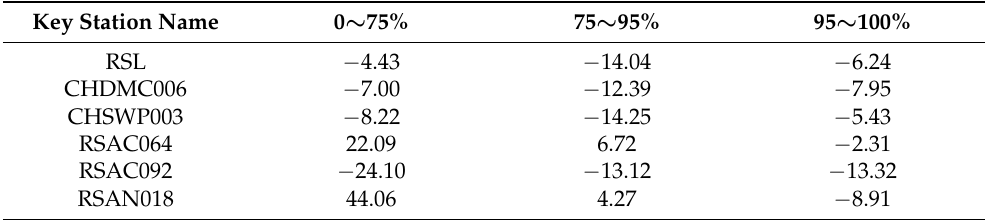
Table A2. Values of ∑ T according to Equation (2).